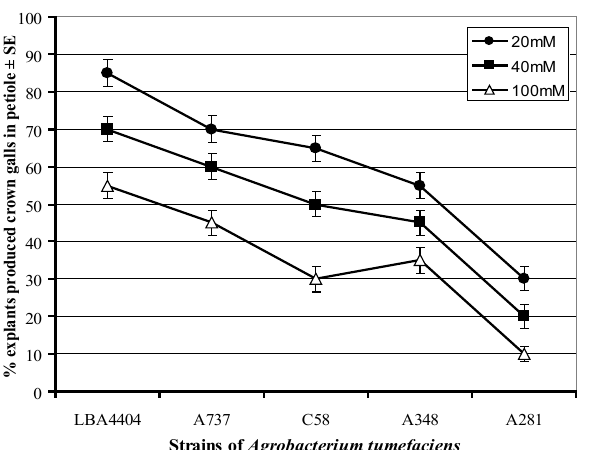
Fig. 8. Effect of acetosyringone on induction of hairy roots in stem of